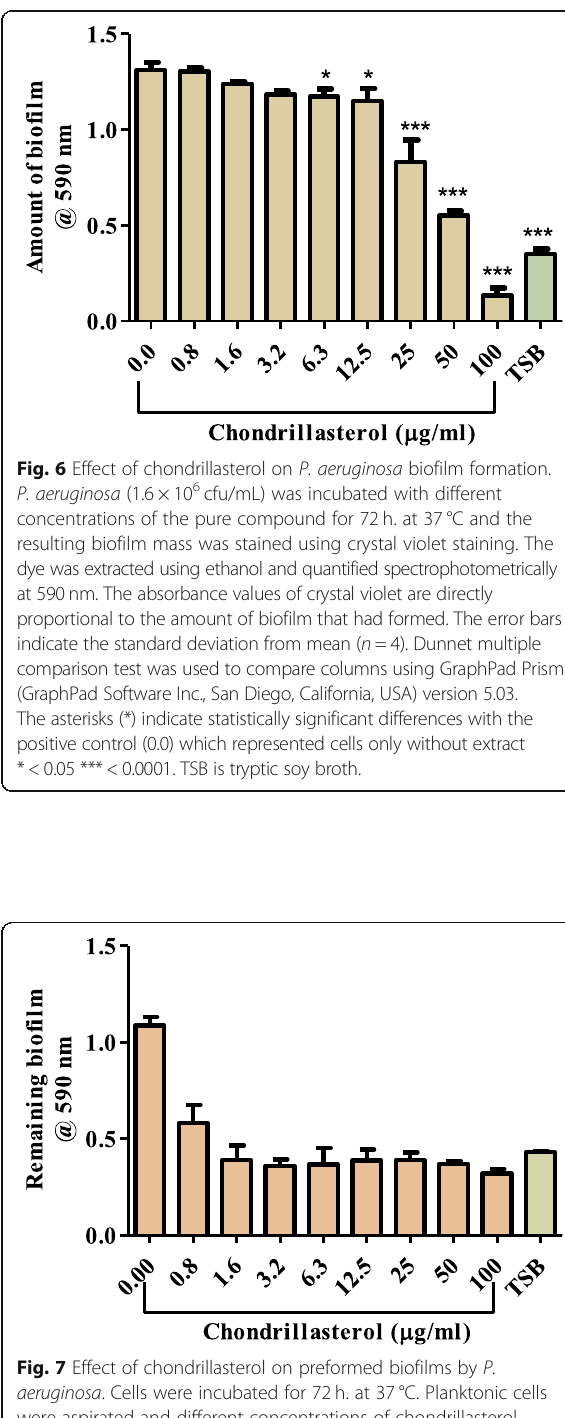
Fig. 7 Effect of chondrillasterol on preformed biofilms by